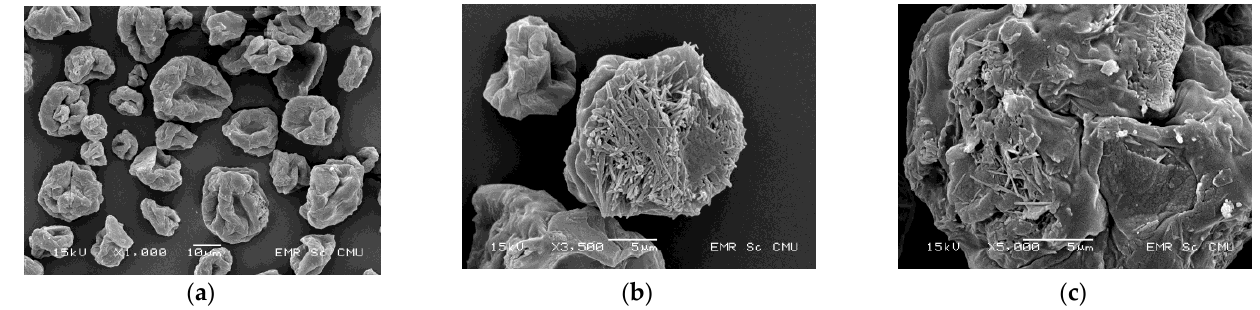
Figure 4. Scanning electron photomicrographs of CCK-R7 at magnification of (a) 1000×, (b) 3500× and (c) 5000×.